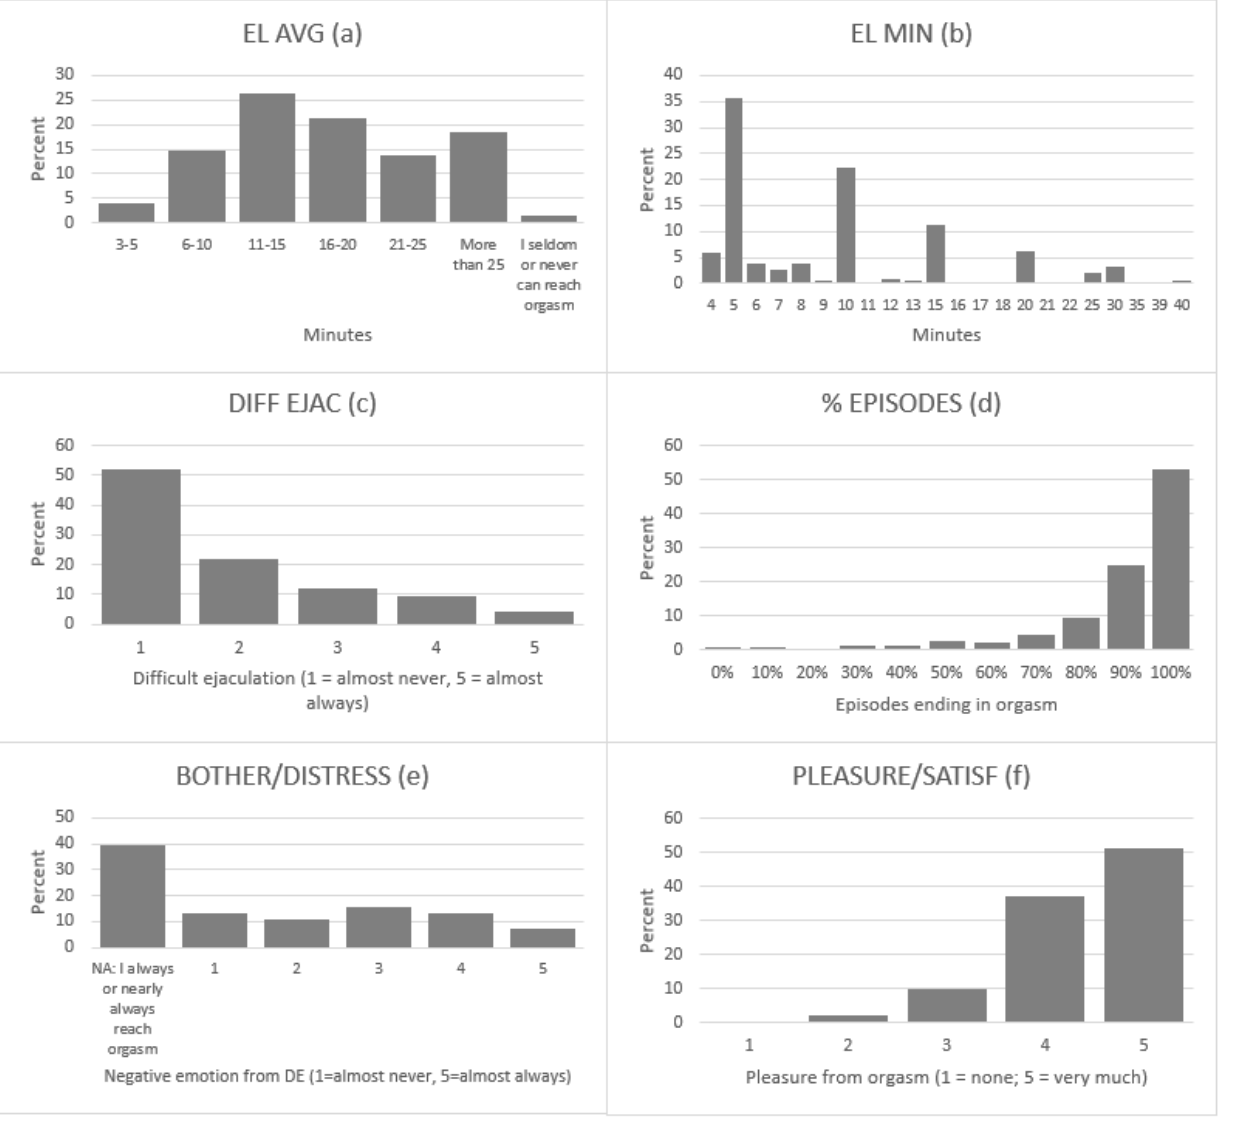
Figure 1. ( a – f ) Distributions of six proposed face-valid items for use as diagnostic measures for DE.